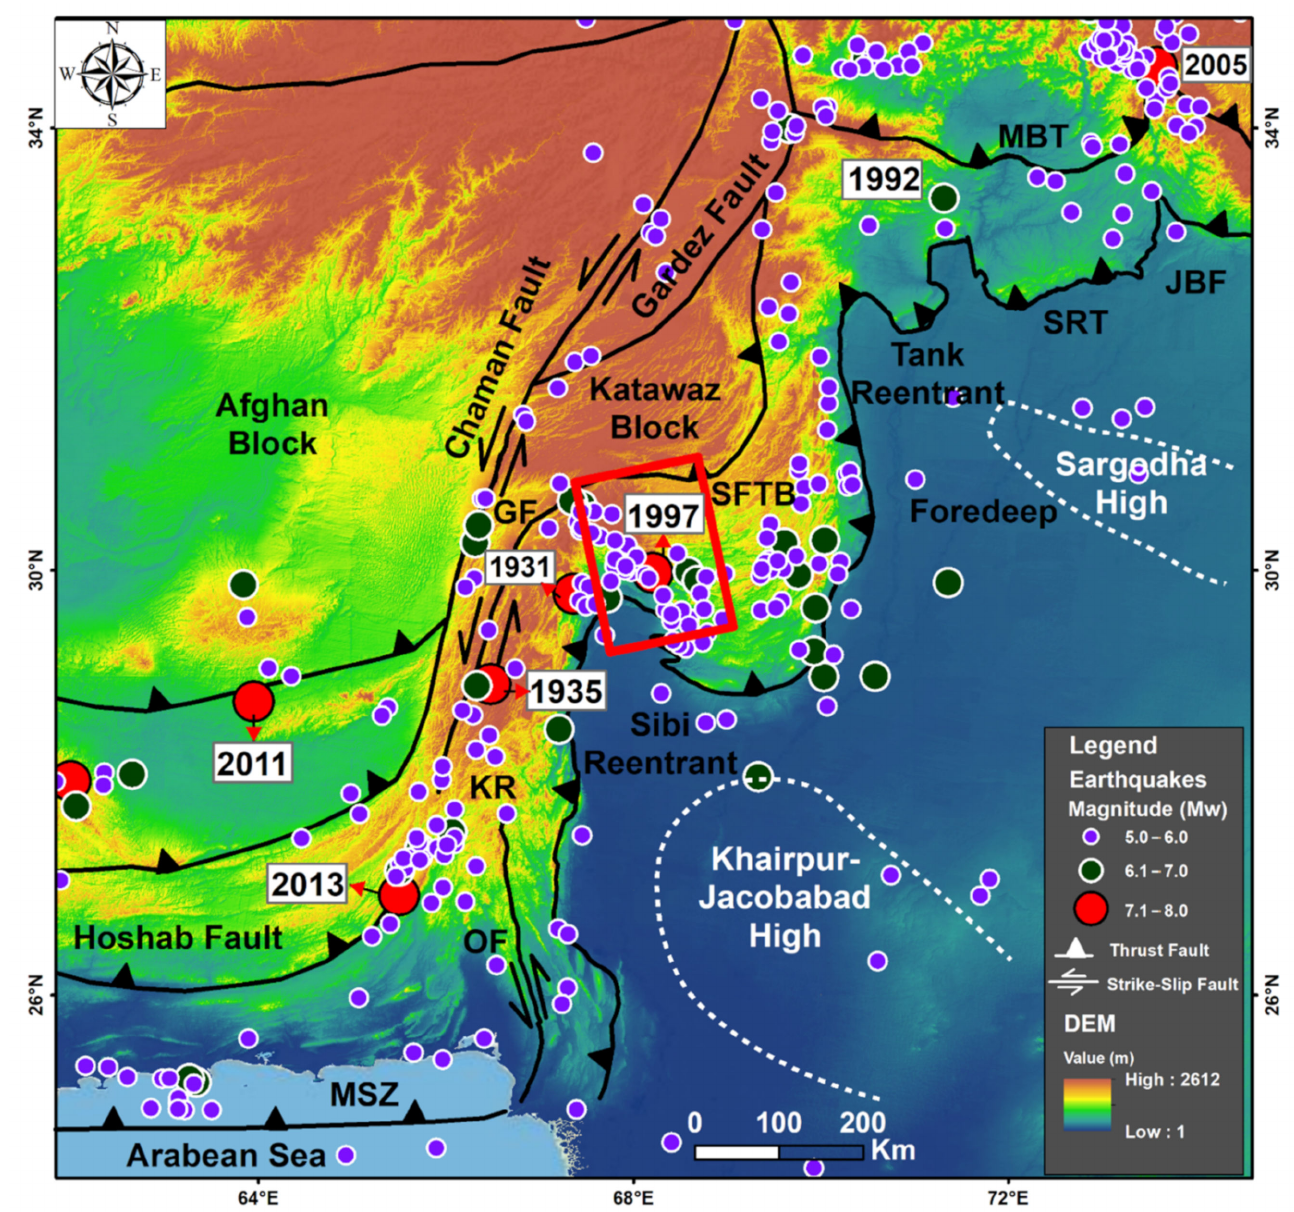
Figure 1. Shuttle Radar Topographic Mission (SRTM) DEM (30 m) showing the regional tectonics of the western Himalaya in Pakistan. The red box indicates the study area near the Sibi reentrant. Earthquakes with magnitude 5.0 or above are shown on the map (data source is USGS Earthquake Catalogue). The earthquakes’ years are highlighted to show highly devastating earthquakes from the last century. Map-view curvature of the SFTB is because of the Sibi and Tank reentrants. MBT, Main Boundary Thrust; JBF, Jhelum Basement Fault; SRT, Salt Range Thrust; SFTB, Suleiman Fold-Thrust Belt; GF, Ghazaband Fault; KR, Kirthar Ranges; OF, Ornachnal Fault; MSZ, Makran Subduction